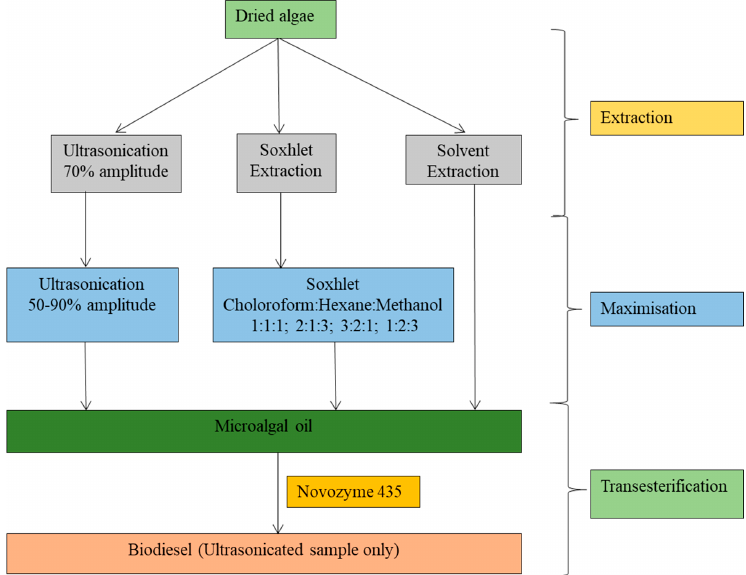
Figure 2. Overall flowchart of lipid extraction of microalgae and biodiesel production.